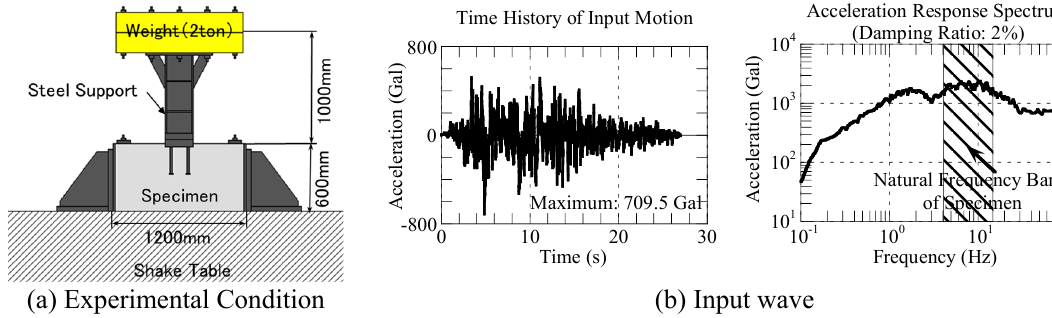
Figure 4. Loading conditions in the shake table test.